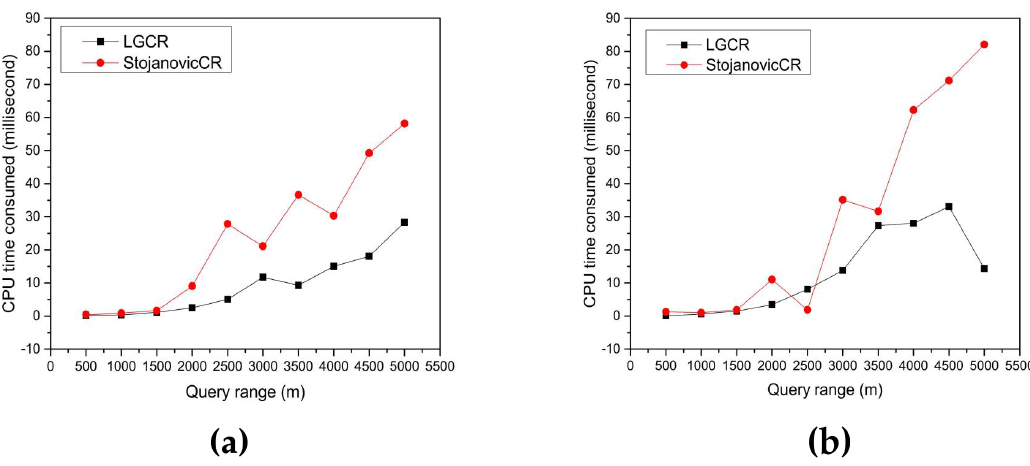
Figure 10. Comparison of Stojanovic continuous range (StojanovicCR) and line graph-based continuous range (LGCR). ( a ) The result of the experiment with 5000 moving objects and 500 query objects; ( b ) The result of the experiment with 10,000 moving objects and 1000 query